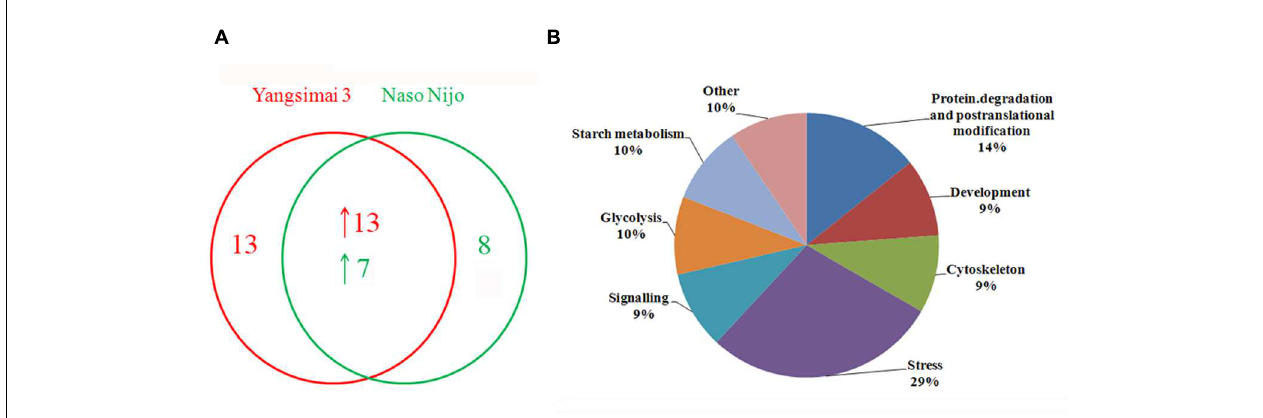
FIGURE 3 | The number of differentially expressed protein spots and protein function category. (A) The number of differentially expressed protein spots; (B) Function category of differentially expressed proteins.